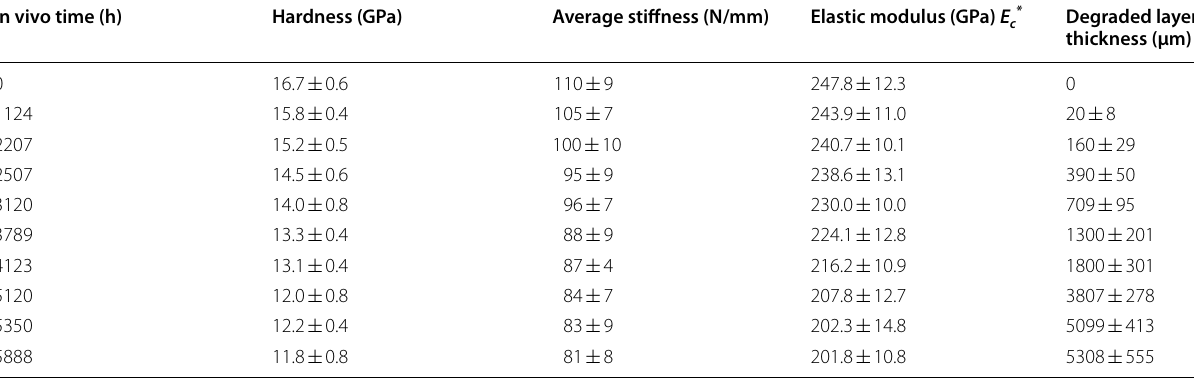
Table 4 Hardness, elastic modulus and degraded layer thickness of the different samples of femoral heads in relation to the in vivo times after implantation In vivo time (h)